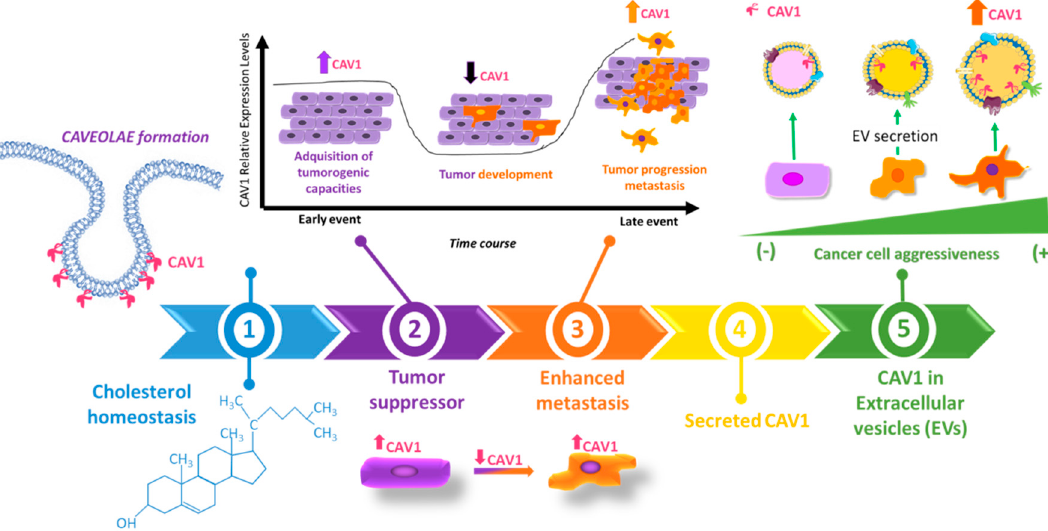
Figure 1. Time line summarizing the evolution of our understanding of Caveolin-1 (CAV1) function.